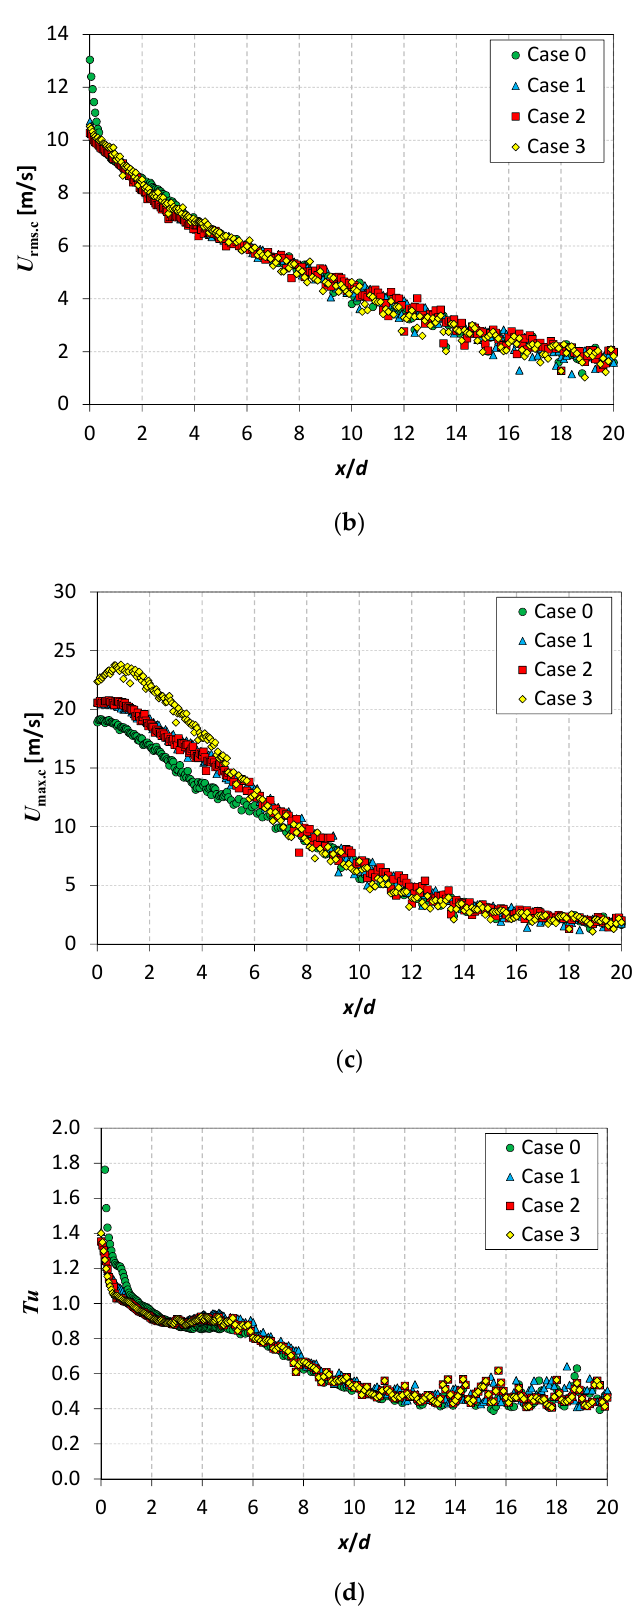
Figure 7. Centerline time-averaged velocity ( a ), centerline momentum velocity ( b ), centerline max- imum velocity ( c ), and centerline turbulence intensity ( d ) as functions of ratio x / d at real power p = 3 W.